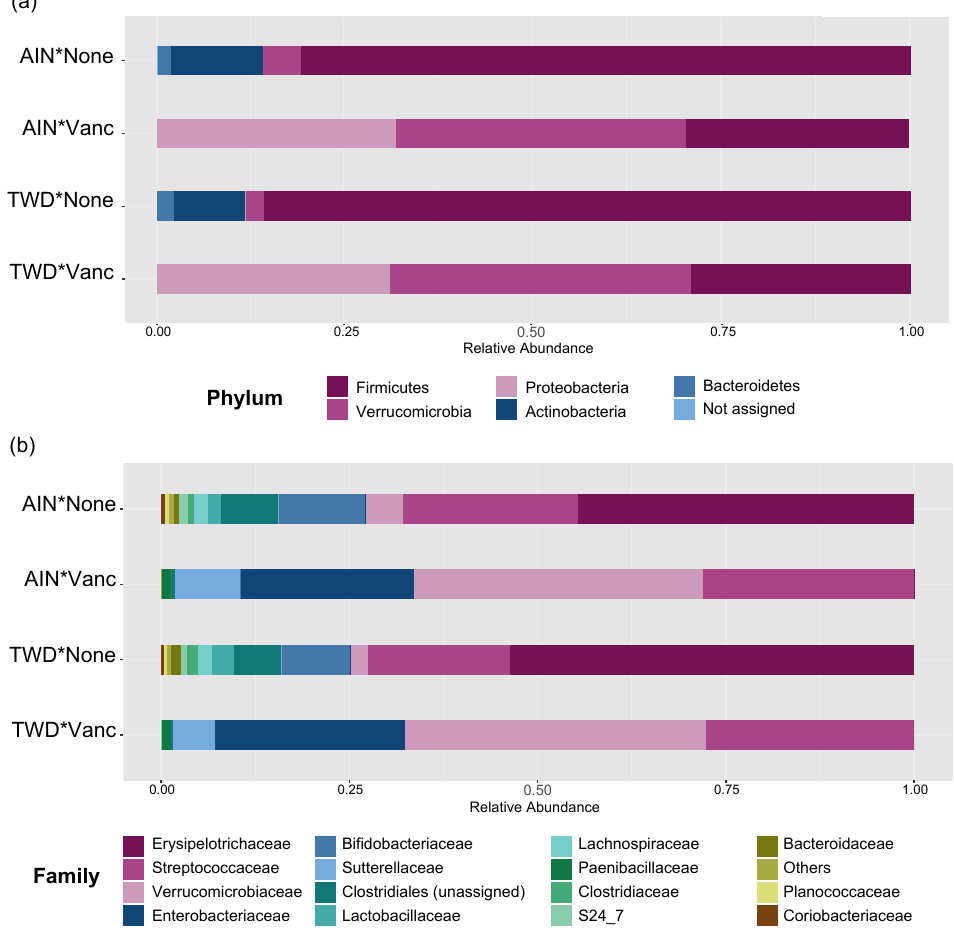
Figure 5. Taxonomic classification of mouse fecal bacteria. Data shown are the relative normalized abundance of bacteria annotated to phyla ( a ) or family ( b ) taxonomic levels for the top 15 most abundant taxa for each experimental group ( n = 17 to 23). Taxonomic classifications for individual animals are provided in supplemental Figure S4. Abbreviations: AIN, the AIN93G diet; TWD, the total Western diet; Vanc, vancomycin.